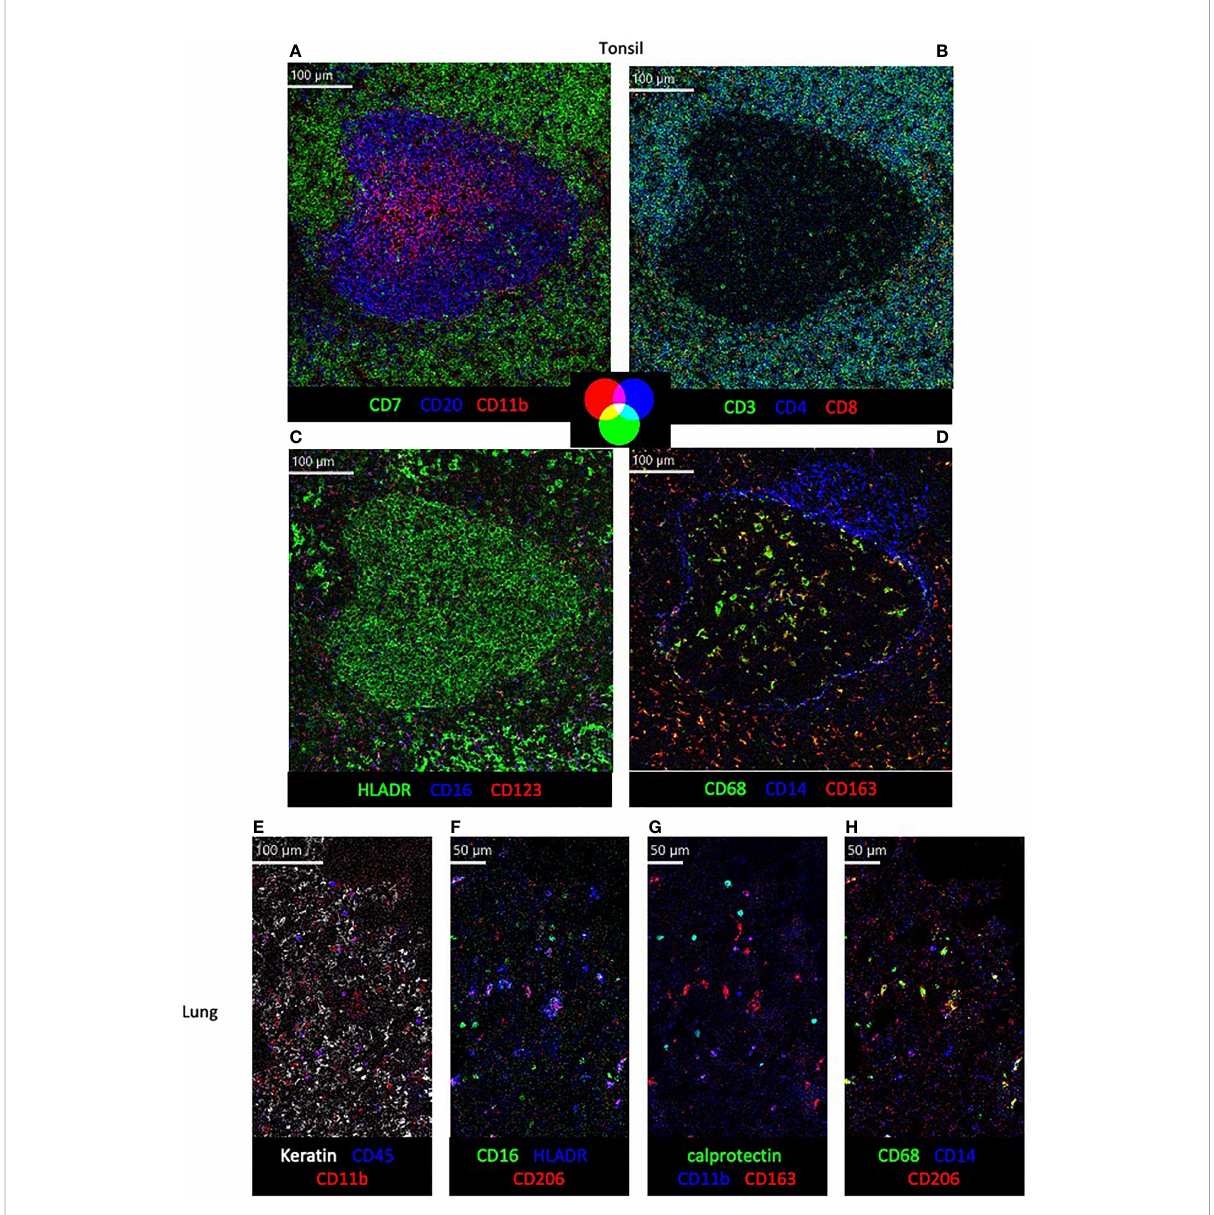
FIGURE 3 Visualization of structural markers and immune cells in non-human primate tissue by imaging mass cytometry. (A – D) in cynomolgus macaque tonsil tissue with color co-expression key. (E – H) Detection of structural (E) and immune subset markers (E – H) in rhesus macaque lung